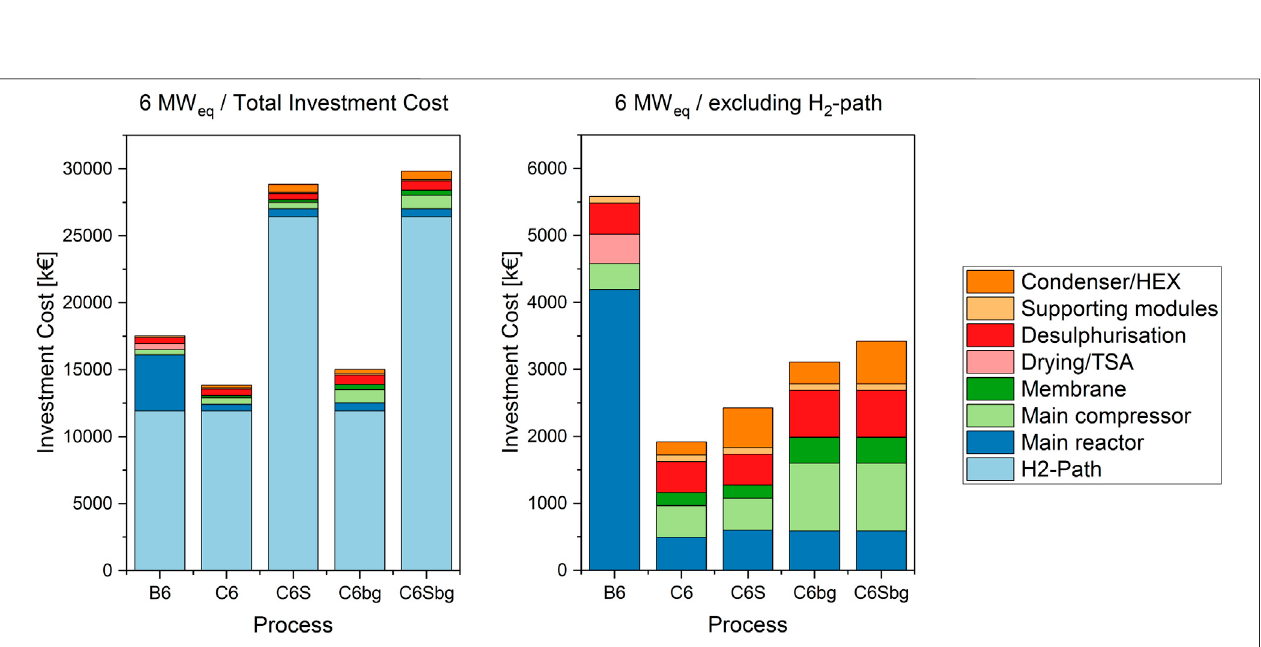
FIGURE 4 | Cost structure of the 6 MW eq cases, including the H 2 -path (left) and focused on the methanation equipment only (right) .